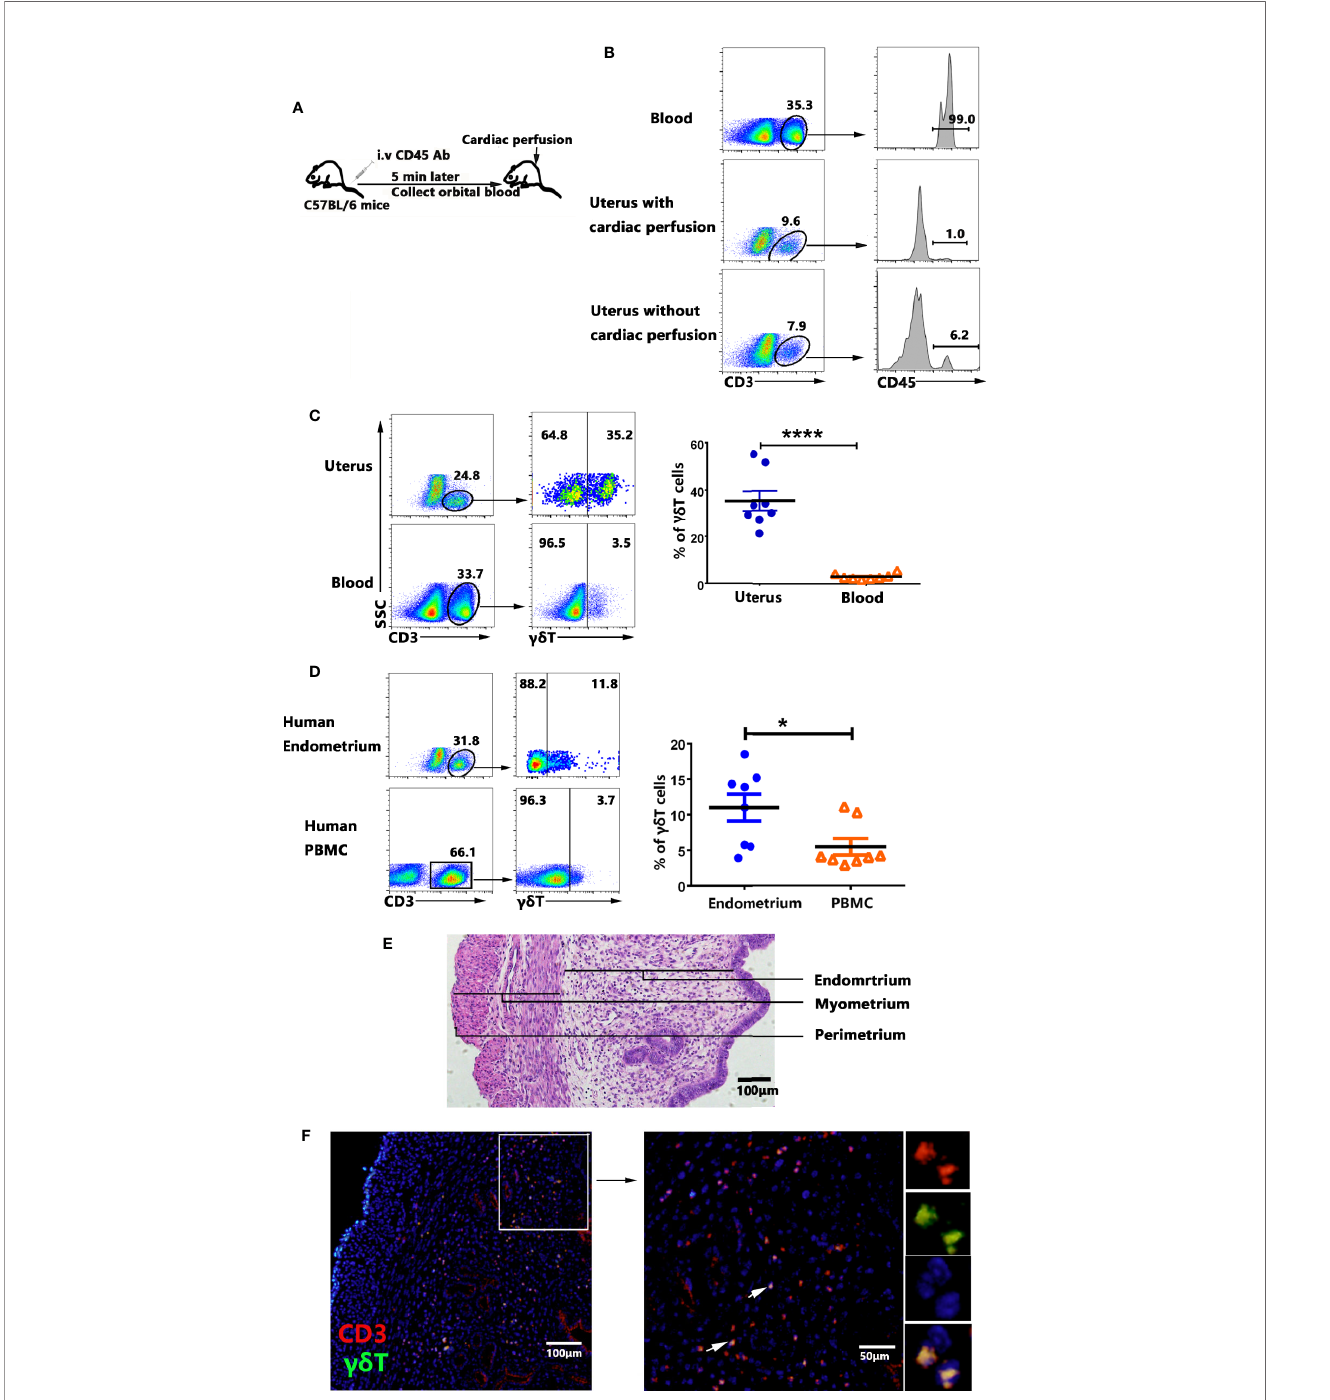
FIGURE 1 | Percentages and tissue localization of gd T cells within uterus. Female mice were intravenously injected (i.v.) with CD45-PE antibody to label the circulating T cells, collected orbital blood after 5 min and removed the blood in tissues by cardiac perfusion (A) . The mononuclear cells from uterus and blood were stained with anti-CD3 and checked for the proportion of CD3 + CD45 + T cells by FACS. Data were representative of three independent experiments with 4 mice per group (B) . The representative graphs and statistical analyses for the percentages of gd T cells in uterus and blood were shown (C) . The representative graphs and statistical analyses for the percentages of gd T cells in human endometrium and peripheral blood were shown (D) . Plots were gated on total live gd T cells. Histology of uterus sections was stained with haematoxylin and eosin (E) . Immuno fl uorescence staining of CD3 (red), gd T cells (green) and DAPI (blue) in paraf fi n-embedded uterus tissues was shown (F) . The arrows display the colocalization of CD3 and gd T cells. The scale bars represented 100 m M (left) and 50 m M (right). The data of each point from six mice were expressed as the mean ± SEM. The statistical signi fi cance was determined with the Mann – Whitney U test. *P < 0.05, ****P <